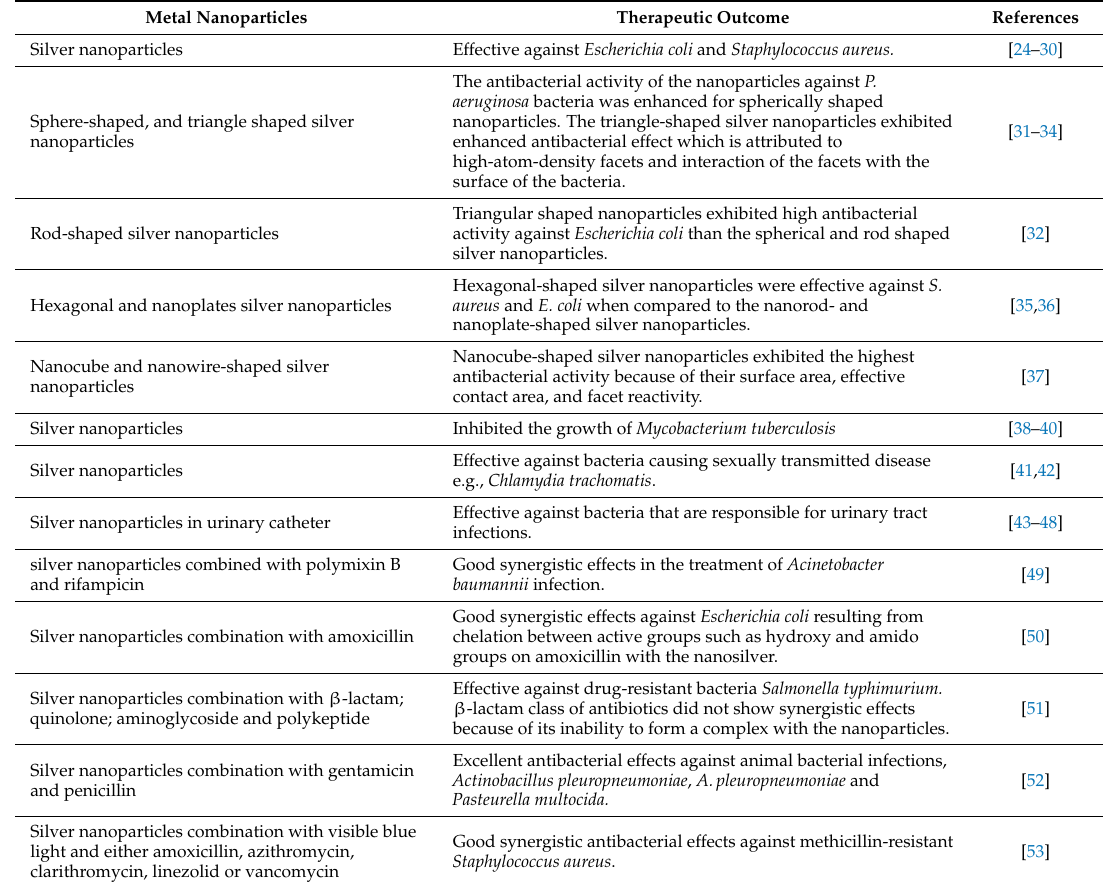
Table 1. Silver nanoparticles with antibacterial activity. Therapeutic